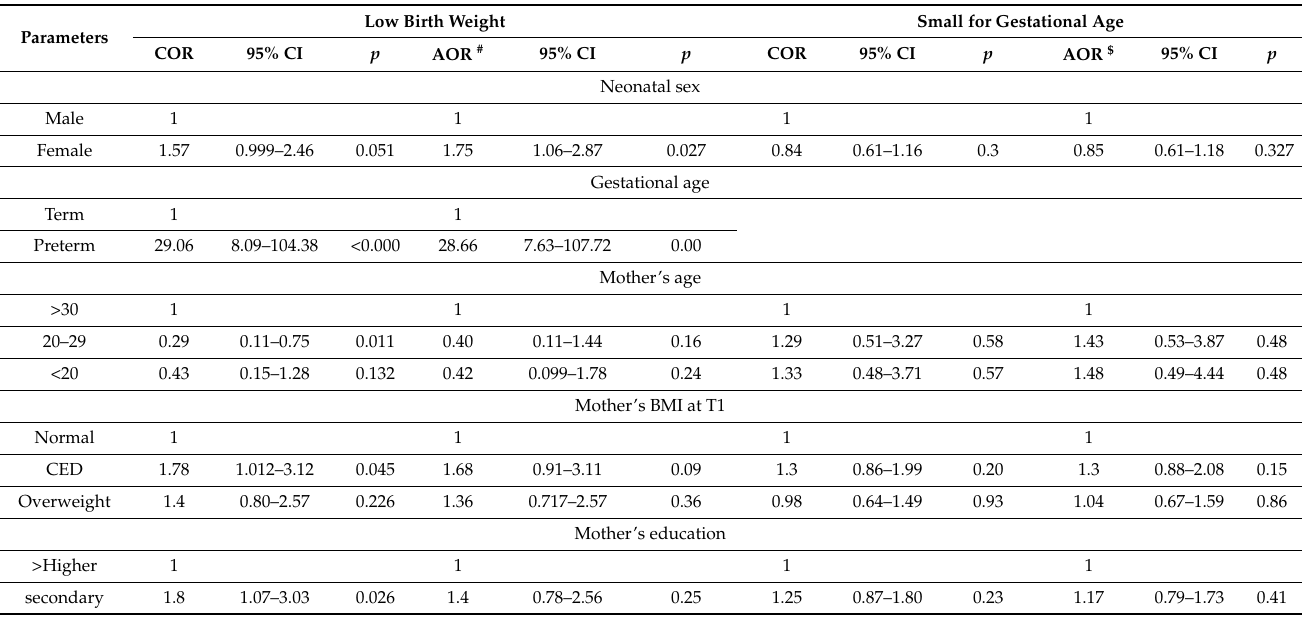
Table 6. Univariate and multivariate logistic regression analysis of predictors for low birth weight and small for gestational